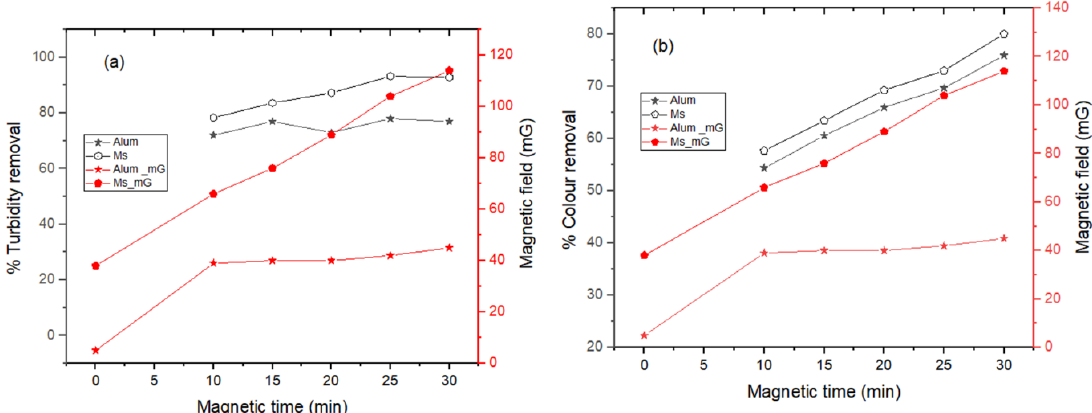
Figure 5. Effect of magnetic field exposure time (10–30 min) on ( a ) turbidity and ( b ) color removal (black scale—left) at dosage of 50 mg/L; Ms_mG, Alum_mG; magnetic field (red scale—right). Table 2. Coagulation summary results with and without magnetic field.